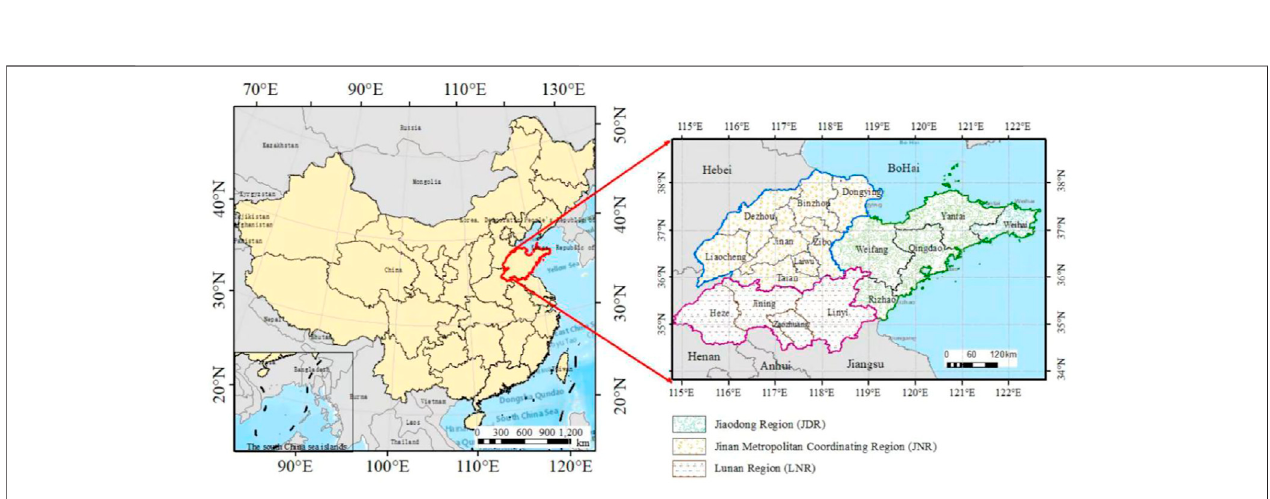
FIGURE 3 | Location and sub-regional divisions of the study area (Shandong